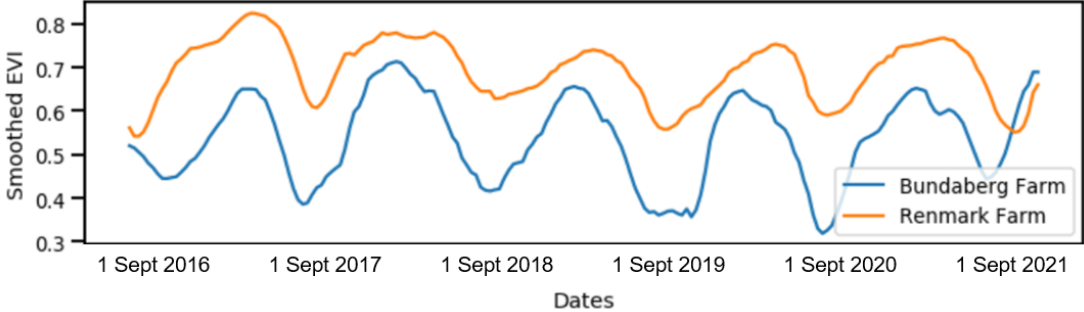
Figure 8. Temporal variability of the EVI trends between the Bundaberg and Renmark avocado farms.